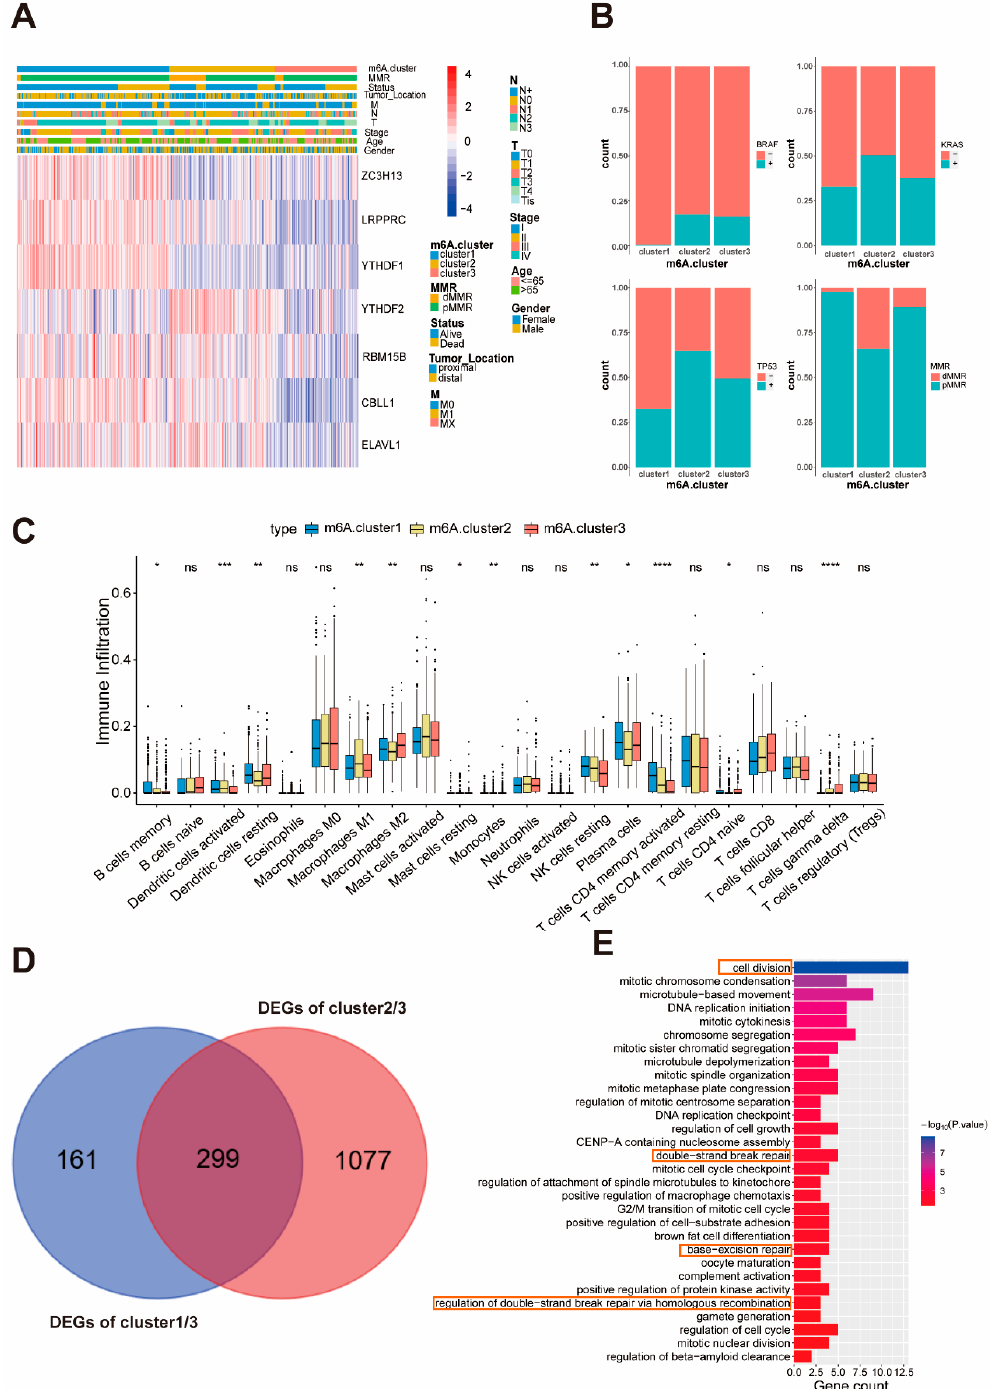
Figure 3. Immune cells and clinical characteristics in the three molecular subgroups. ( A ) Unsupervised clustering of seven m6A regulators in the GSE39582. The m6A.cluster, stage, status, M, N, T, age and gender were used as patient annotation. Red represents high expression of regulators and blue represents low expression. ( B ) Difference in the clinical features including BRAF/KRAS/TP53 mutant and MMR status among three m6A.cluster. ( C ) The abundance of each immune cells in the three m6A.clusters. The upper and lower ends of the boxes represent the interquartile range of values. The lines in the boxes represent the median value, and the black dots show the outliers. The asterisks represent the statistical p -value (* p < 0.05, ** p < 0.01, *** p < 0.001, **** p < 0.0001). ( D ) 299 m6A-related phenotype-related genes shown in Venn diagram. ( E ) Functional annotation for m6A-related genes using GO enrichment analysis. The orange boxes represent signaling pathways involved in DNA repair and cell